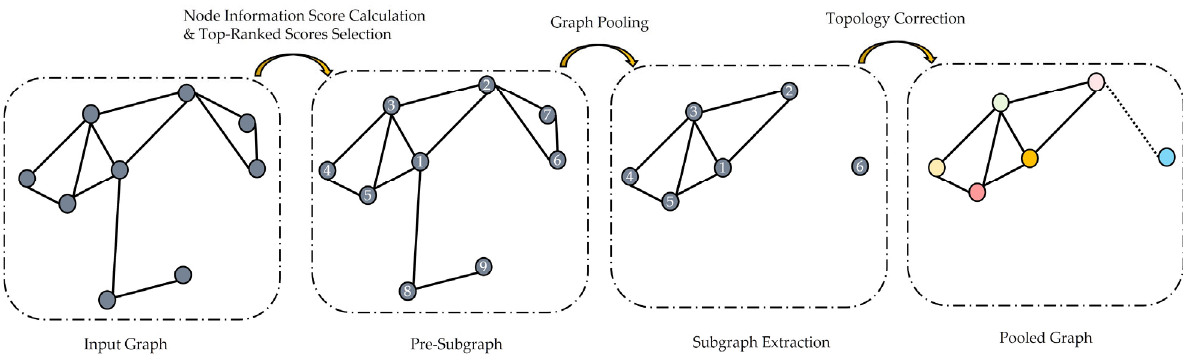
Figure 7. Details of structure learning mechanism.